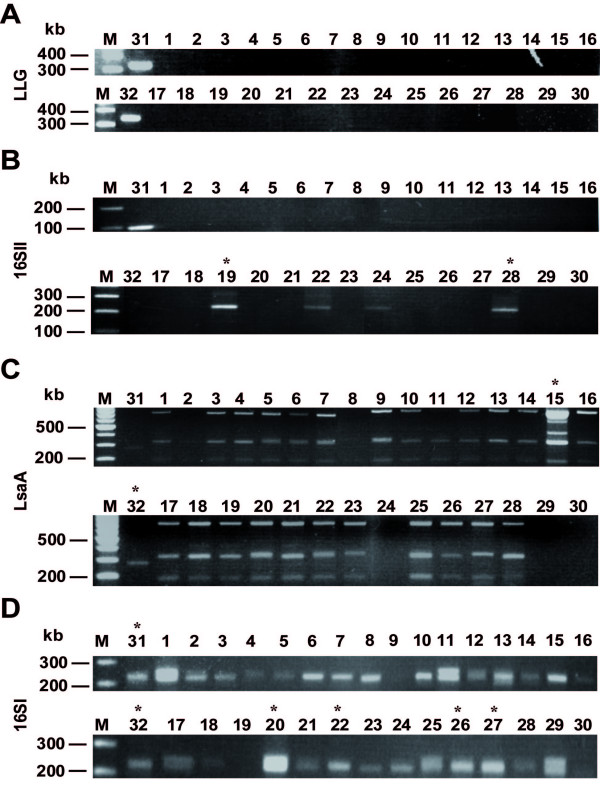
Detection of Lawsonia intracellularis DNA in intestinal specimens by PCR using different sets of primers. Bacterial DNA was prepared from intestinal specimens obtained from organ donors and IBD patients as described in Material and Methods, and PCR-amplified using primers recognizing lyase-like gene (LLG, A), 16S ribosomal subunit (set II, B and set I, D), and Lawsonia surface antigen (LsaA, C). The sample numeration is as described in Table 1. (31, 32) depict porcine fecal DNA samples used as positive controls; (*) – samples used for sequencing.